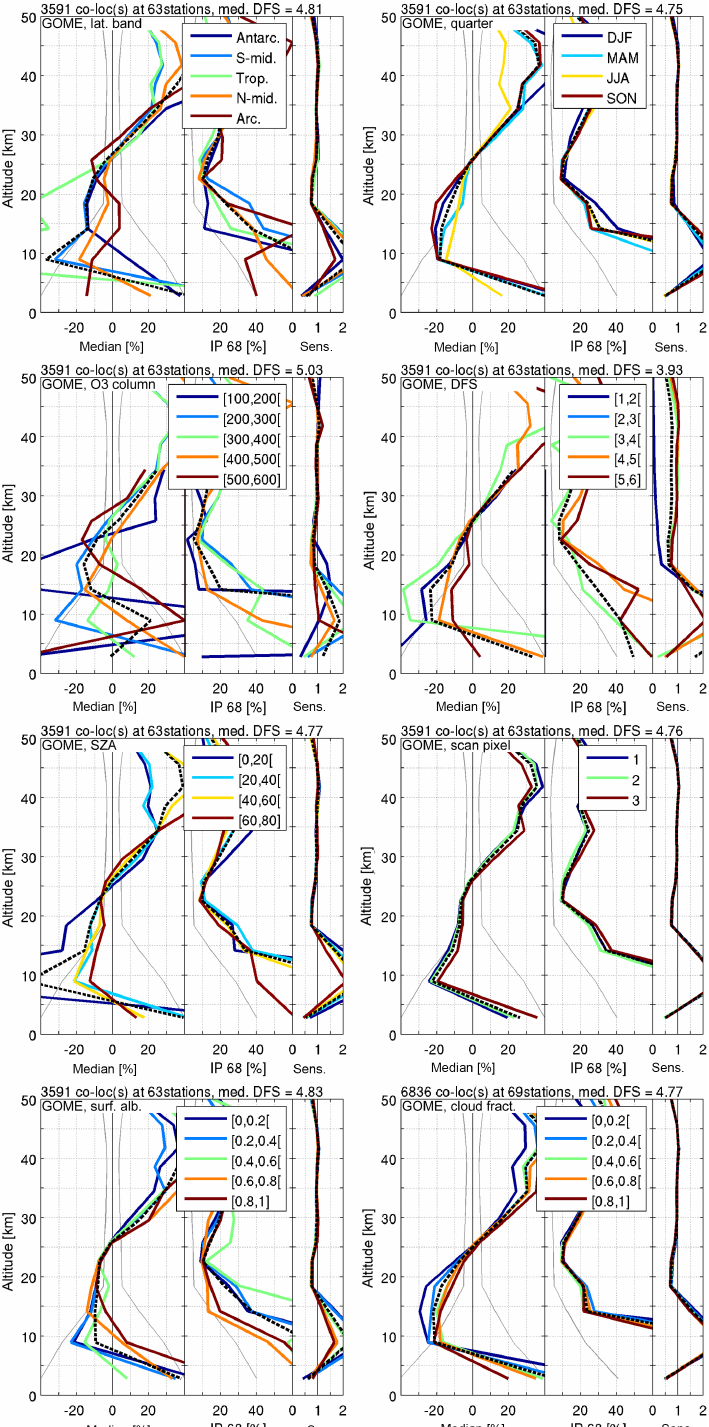
Figure 6. Median relative differences, 68% interpercentile spreads, and vertical sensitivities for comparison of RAL v2.14 L2 GOME retrieved profiles with ground-based reference measurements (1996–2010). The same difference and information statistics are redistributed in each plot over several influence quantity ranges, with the influence quantities being (from left to right and top to bottom panels) latitude, quarter, total ozone column (DU), DFS, SZA, scan pixel index, surface albedo, and effective cloud fraction. In the corresponding legend entries, open brackets are used to indicate that the last value is not included (i.e. values in the set go up to, but do not equal, the last value). The black dashed line shows the average of the coloured curves, while light grey lines indicate the satellite uncertainty provided in the product. The number of comparisons is higher for the latter as the ECF filter has been switched